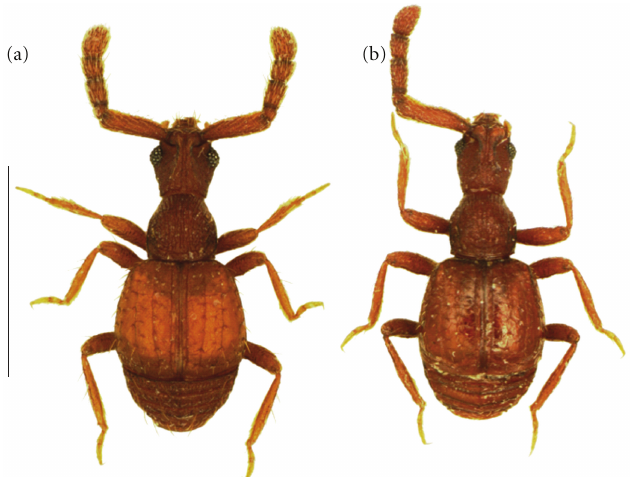
Figure 2: (a) Paragoniastes uesci , male, macrophthalmus (paratype). (b) P. westwoodi , male, macrophthalmus (holotype). Scale bars: 1mm.